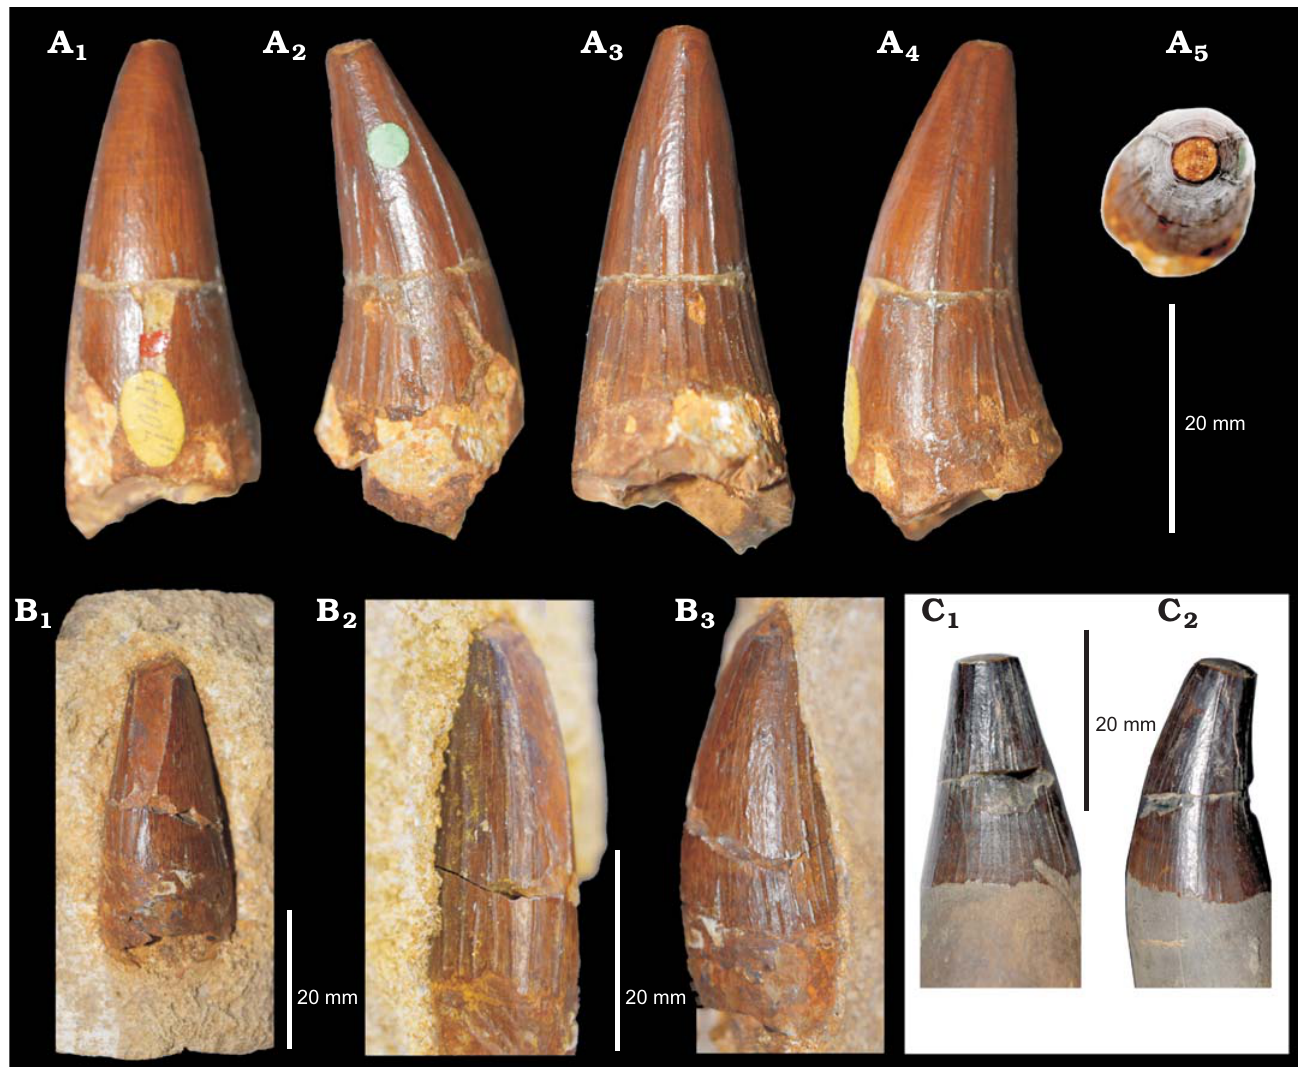
Fig. 5. Teeth of the pliosaurid reptile “ Pliosaurus ” grossouvrei Sauvage, 1873 (A, B) and “ Pliosaurus ” andrewsi Tarlo, 1960 (C). A . NHMUK PV OR 47044, from Malton (Yorkshire), middle Oxfordian, in labial (A 1 ), axial (A 2 , A 4 ), lingual (A 3 ), and apical (A 5 ) views. B . NHMUK PV OR 47971a, from Malton (Yorkshire), middle Oxfordian, in labial (B 1 ), axial (B 2 ), and oblique axial/labial (B 3 ) views. C . NHMUK PV R3891, from Peterborough (Cambridgeshire), Callovian, in lingual (C 1 ) and axial (C 2 )